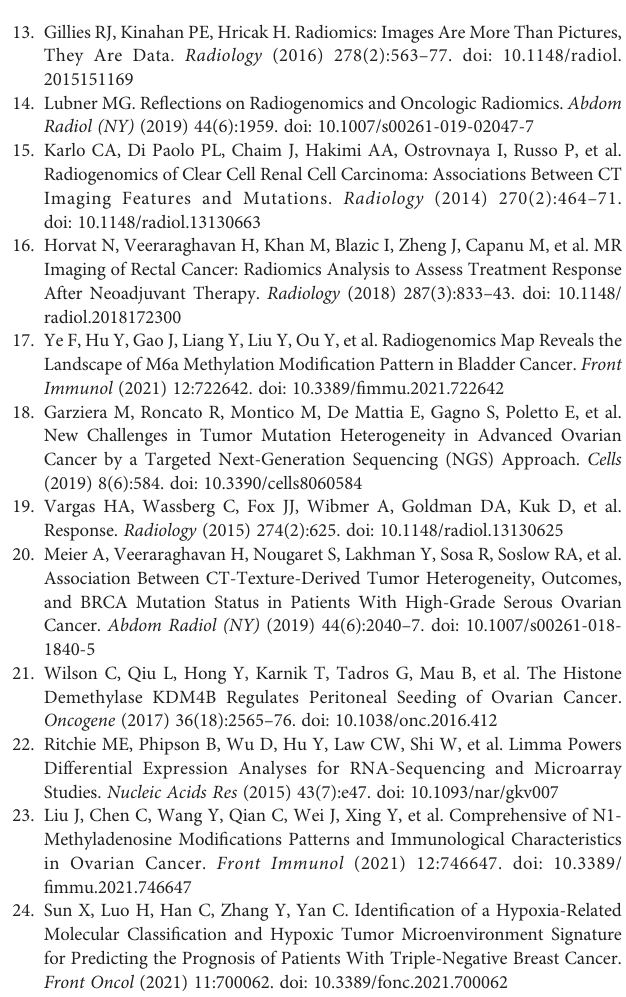
Supplementary Figure 1 | Identi fi cation of independent prognostic value and Nomogram. (A) Forest plot of univariate Cox regression analysis in the TCGA cohort. (B) Forest plot of multivariate Cox regression analysis in the TCGA cohort. (C) Forest plot of univariate Cox regression analysis in the GEO cohort. (D) Forest plot of multivariate Cox regression analysis in the GEO cohort. (E) Nomogram. (F) Calibration curve of nomogram for OS prediction at 1 year, 3 years, and 5-years in